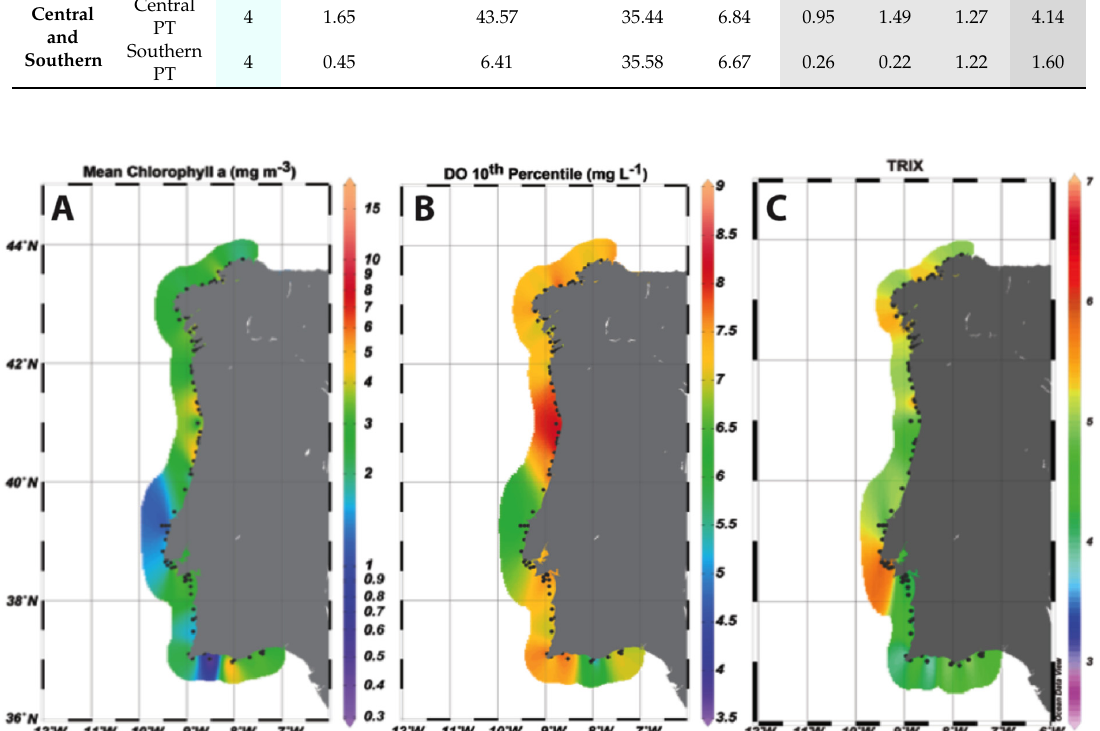
Figure 9. ( A )MeanChl a (mgm − 3 ); ( B )Dissolvedoxygen(DO)10th%ile(mgL − 1 ); ( C Figure 9. ( A ) Mean Chl a (mg m − 3 ); ( B ) Dissolved oxygen (DO) 10th %ile (mg L − 1 ); ( C ) Trophic index values.